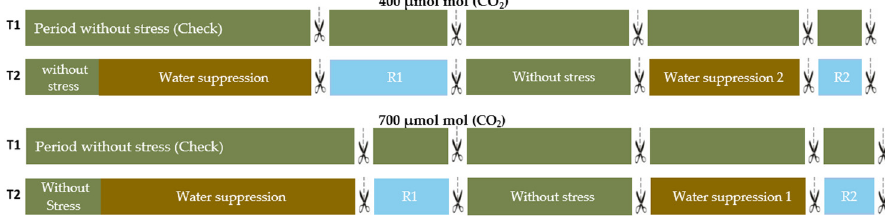
Figure 1. Distribution of treatments, where T1 = fully irrigated T2 = experienced water deficit, Water 1 suppression = first water suspension in the growing season, Water suppression 2 = second water suspension when plants have reached 50% of the reproductive period. R1 and R2 = rehydration period.